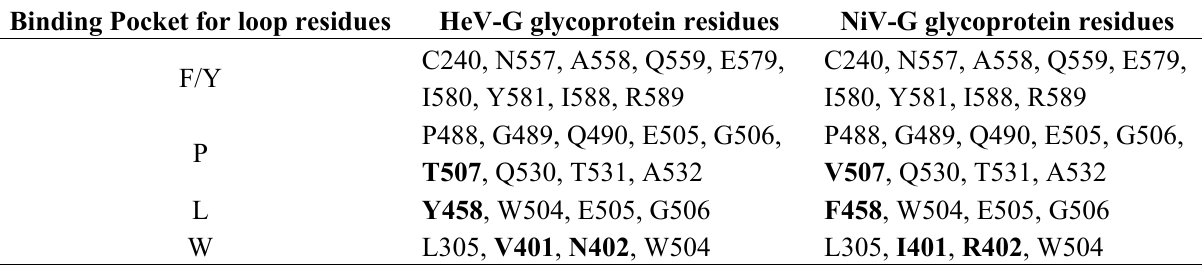
Table 1. Henipavirus G glycoprotein receptor binding pockets. The residues in HeV-G and NiV-G that form the binding pockets for the residues of the ephrin-B2 and ephrin-B3 G-H loop are shown. The residues are highly conserved with those in bold-face indicating the four amino acids that are different between the HeV-G and NiV-G binding pockets for Eprhin-B2 and -B3 P122, L124 and